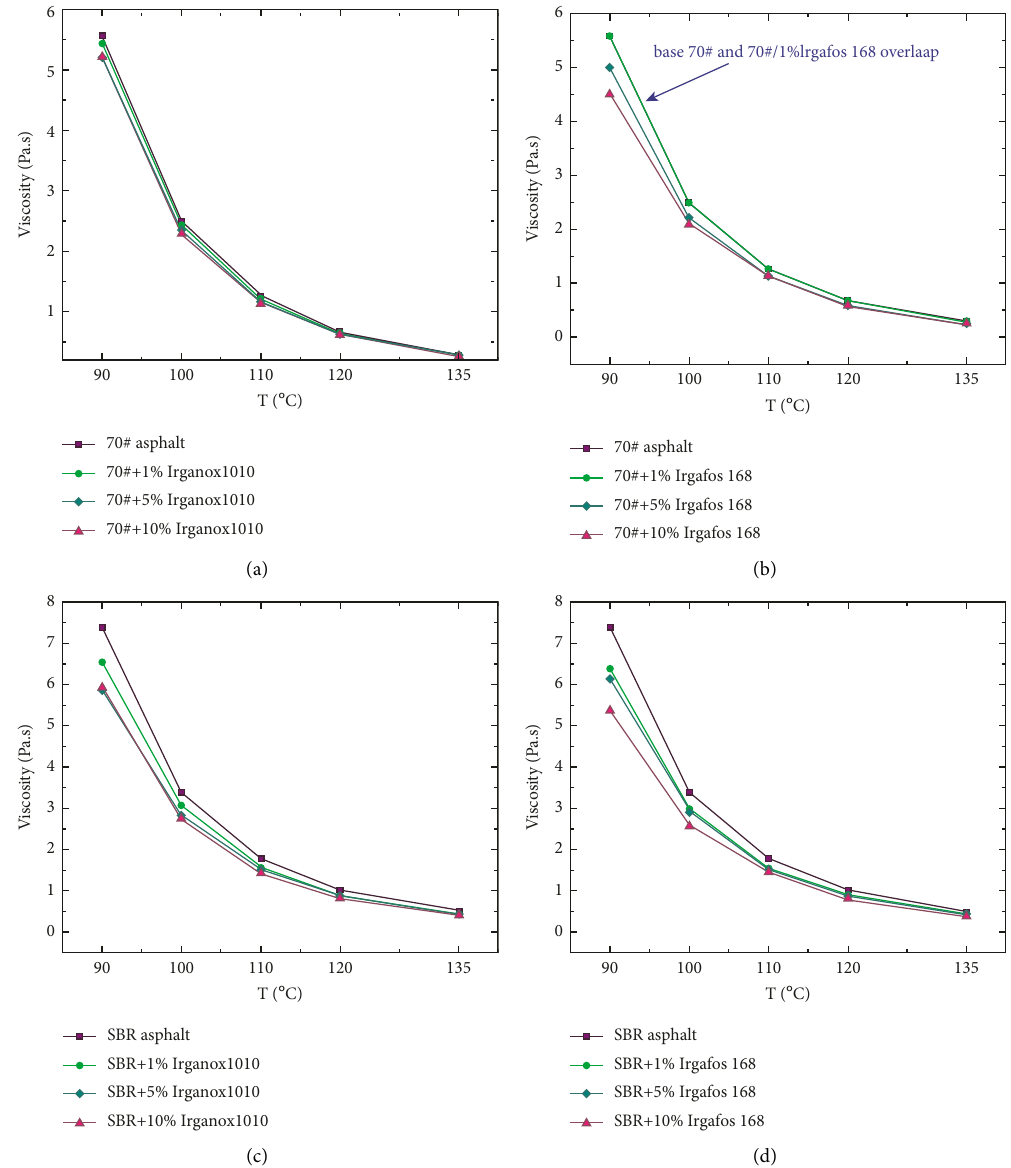
Figure 2: Viscosities of virgin and modified